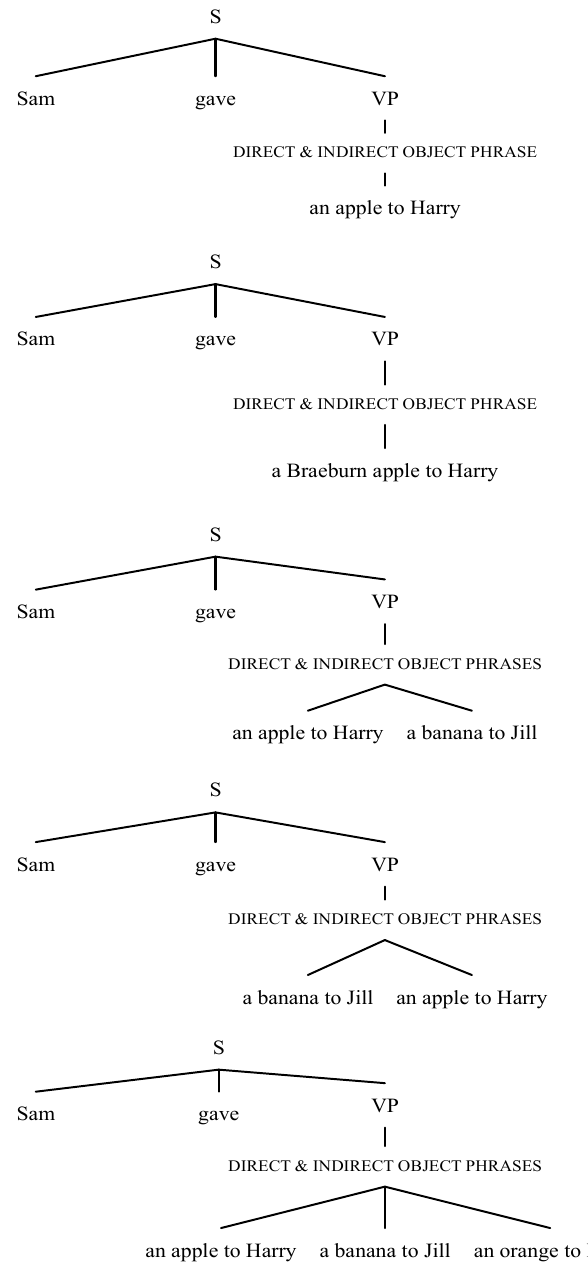
Figure 2. Hierarchical Structuring.